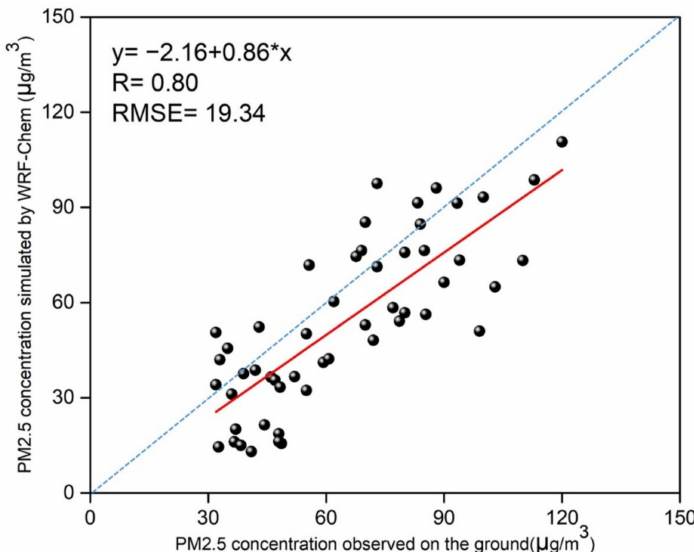
Figure 4. The precision validation of the WRF-Chem model in the E-NCP